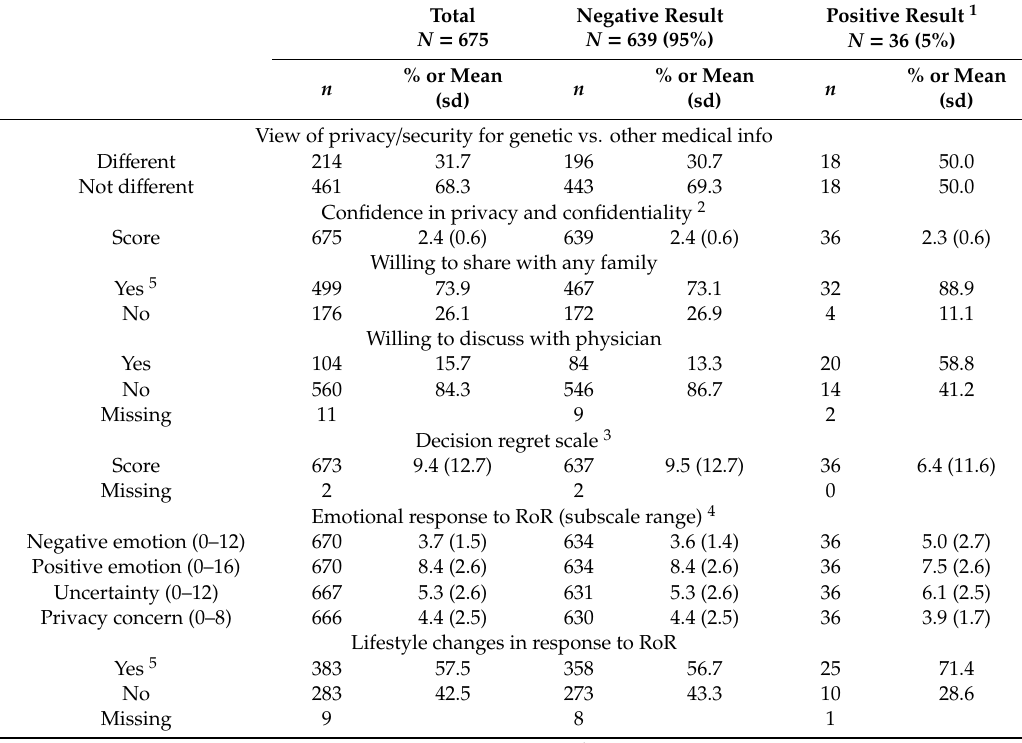
Table 2. Distribution of survey responses by result type ( n =